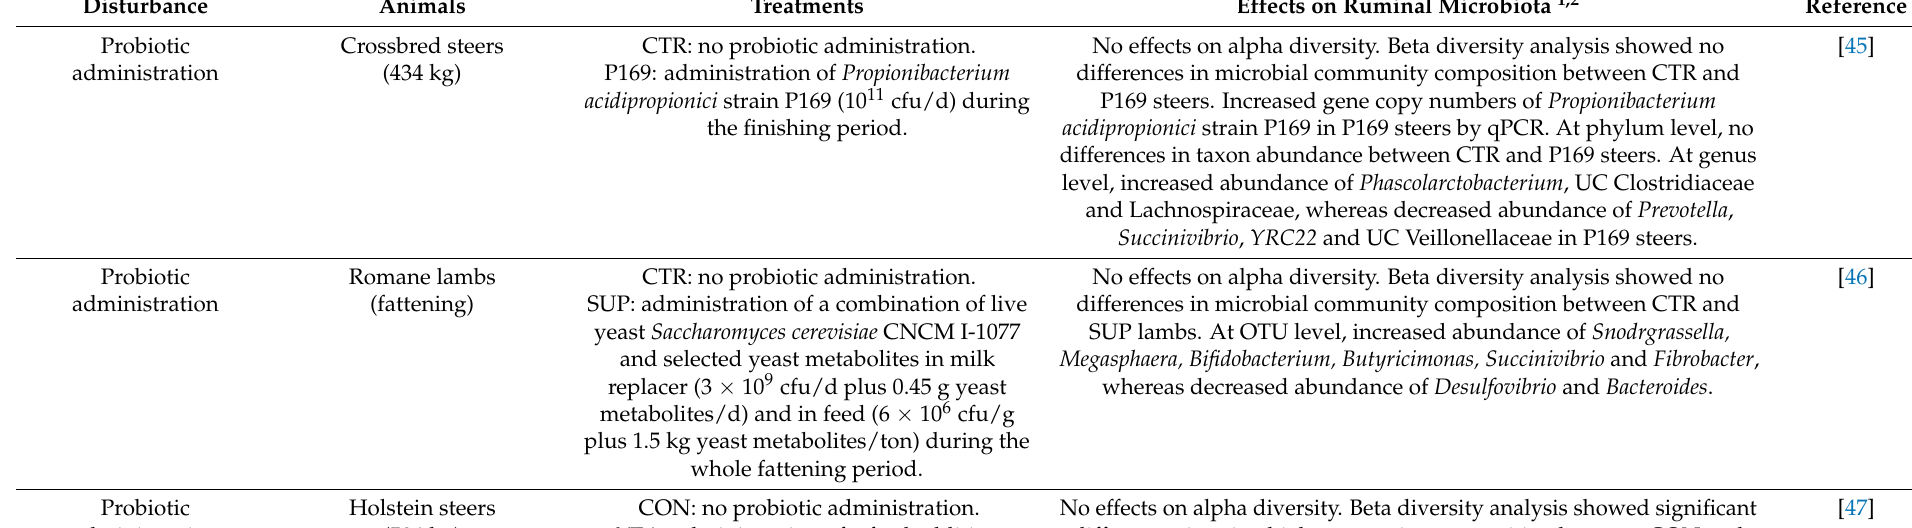
Table 3. Main effects of ramp disturbances on ruminal microbiota (bacteria and